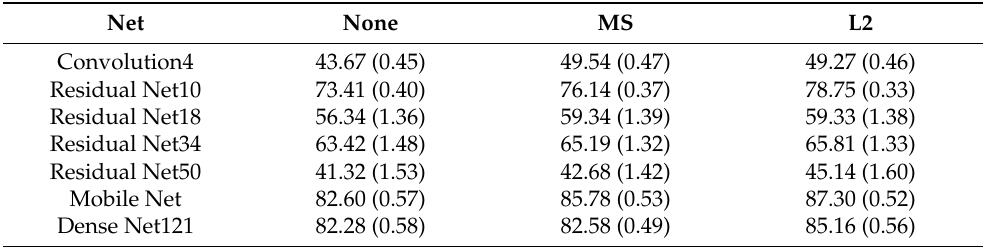
Figure 5. Average accuracy of different classification networks during training. Tables 2 and 3 quantitatively show the results of multiple feature extraction networks and feature transformations. In Tables 2 and 3, Net indicates feature extraction networks, None indicates no transformation, MS indicates Mean Subtraction and L2 indicates L2- normalization. Moreover, the value before parentheses is the average accuracy and the value inside parentheses represents the confidence interval radius under the confidence level of 0.95. Take Table 2 for example: when MobileNet is used as the feature extraction network, and L2-normalization is adopted as the nearest neighbor classification method, the average classification accuracy of the steel surface defects is 87.30% and the confidence interval radius is 0.52%. Table 2. 1-shot setting, the average accuracy rate of different classification networks, in %.